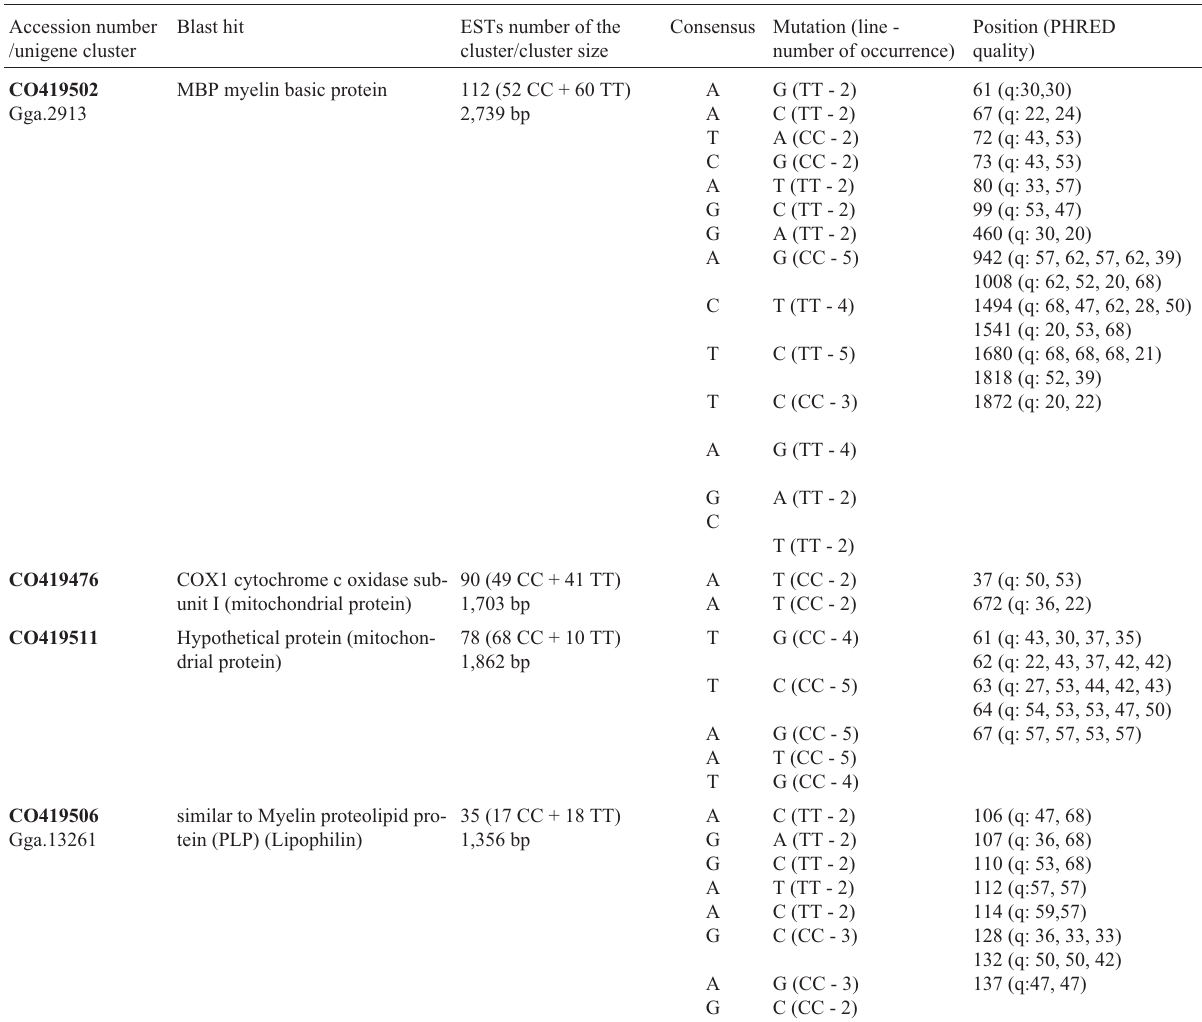
Table 1 - Relation of putative line specific SNPs found in 28